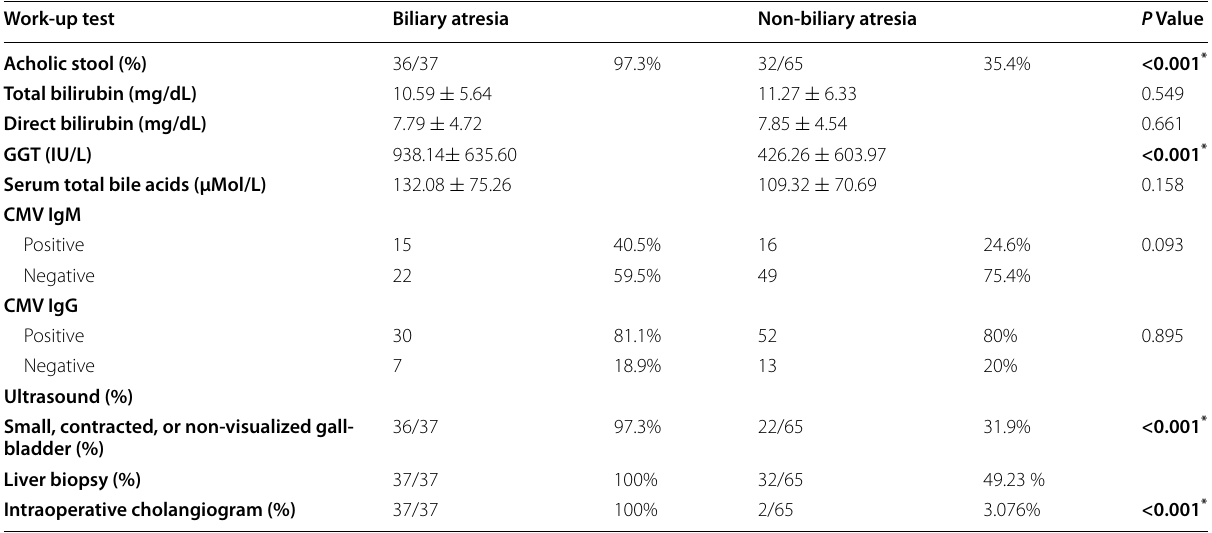
GGT Gamma glutamyl transaminase, CMV IgM cytomegalovirus immunoglobulin M, CMV IgG cytomegalovirus immunoglobulin G